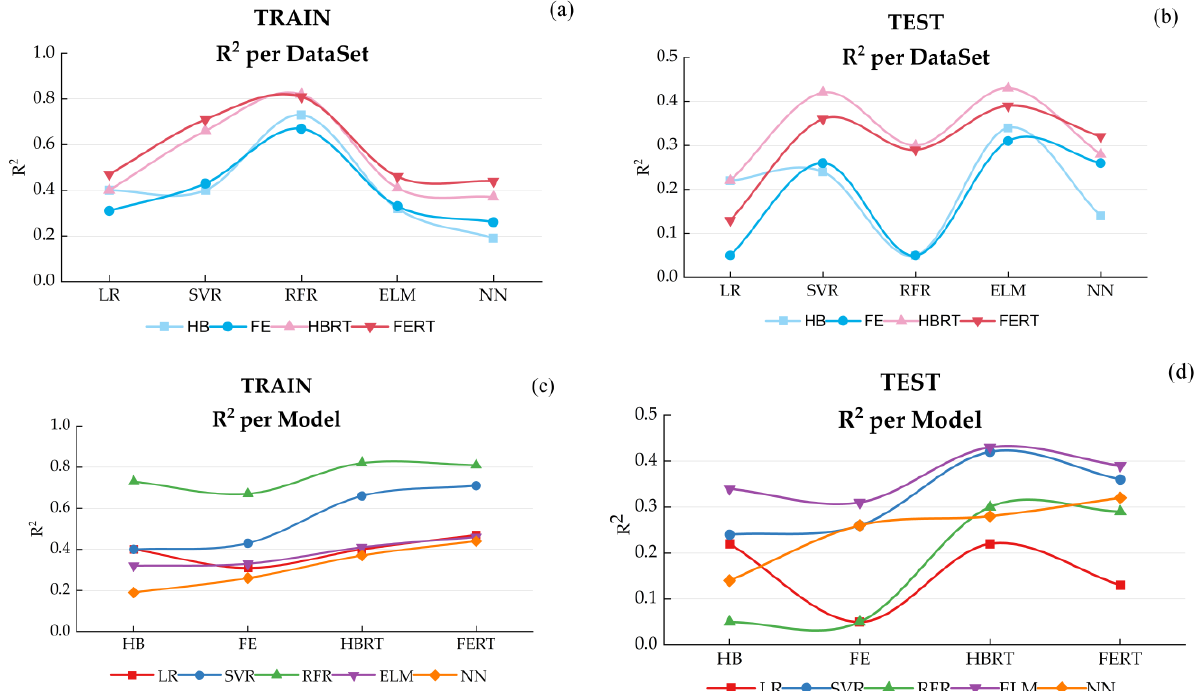
Figure 6. Train and test average R 2 for each algorithm and dataset. In ( a , b ) improvement is noticeable when using datasets that have the RT features which are colored in red for both train and test phases. Similarly, the increase in the performance is seen on all the models when using an HBRT or FERT dataset, ( c , d ).